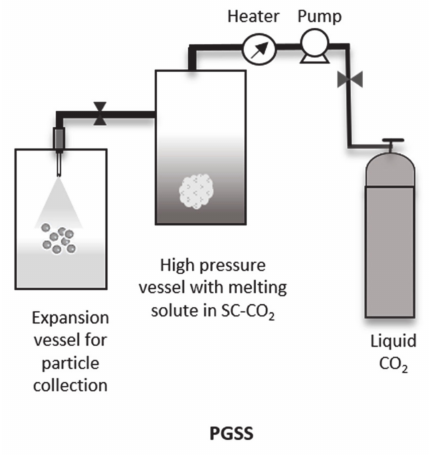
Figure 5. Schematic representation of PGSS